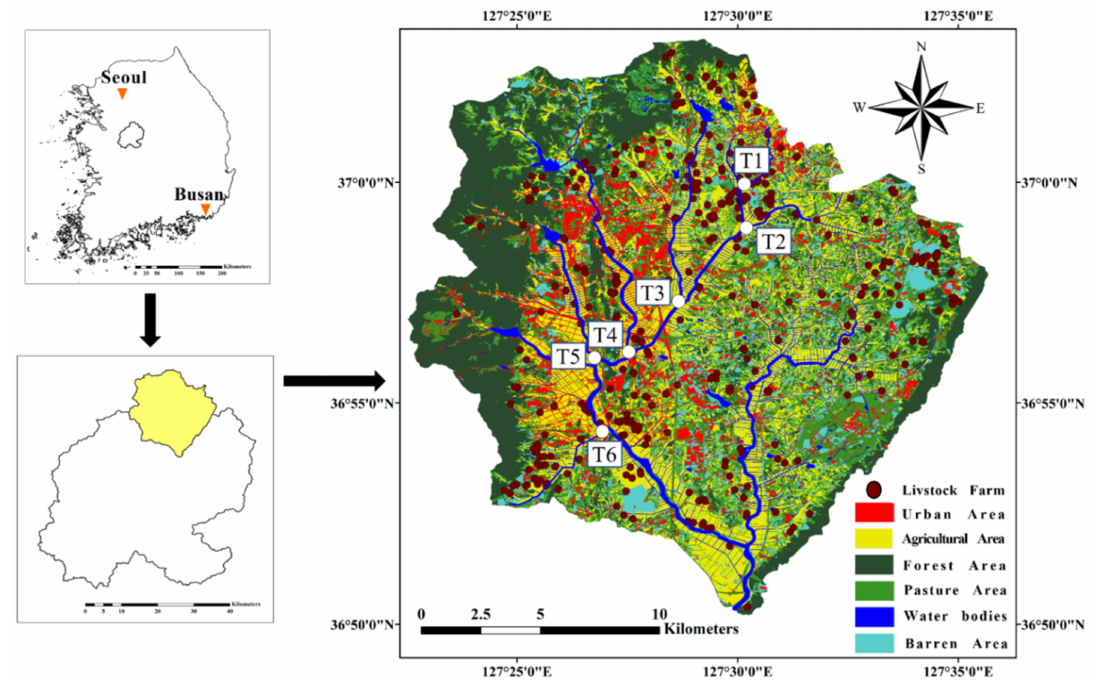
Figure 1. Location of sampling sites in the Miho upstream watershed; white circles indicate the sampling locations (T1: Naetgeureum Stream, T2: Dochung Stream, T3: Sungsan Stream, T4: Chiljang Stream, T5: Guam Stream, T6: Jungsan